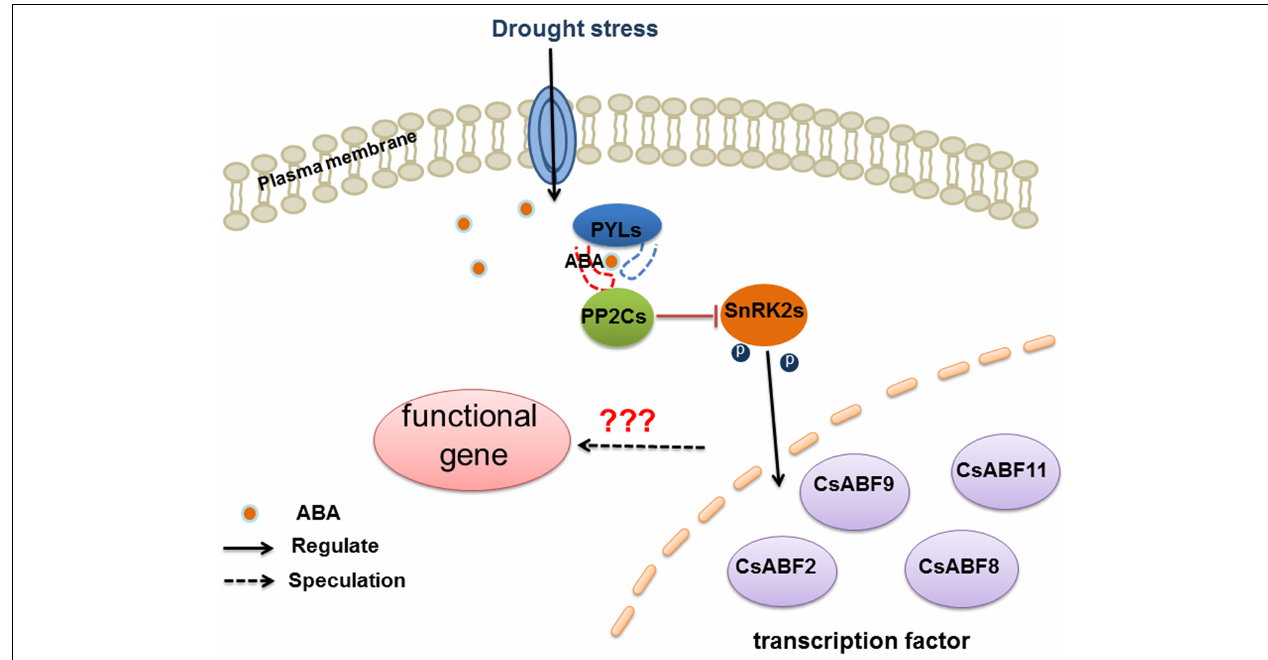
FIGURE 7 | Model diagram of CsABFs responds to drought stress through the ABA signaling